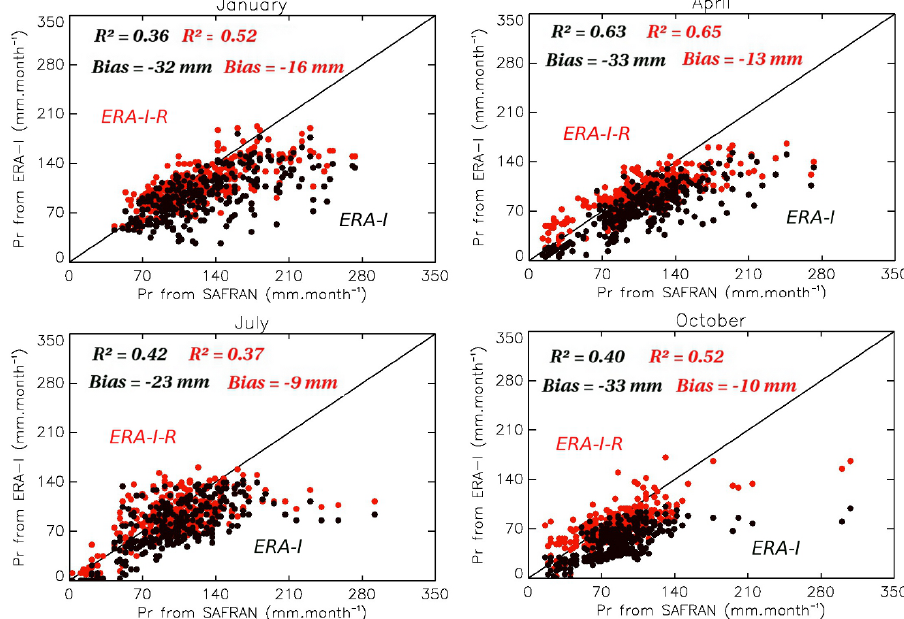
Fig. 6. Spatial correlation of the monthly precipitation data from ERA-I and ERA-I-R (308 grid-cells) with SAFRAN, in January, April, July, and October 2001. Table 3. Representation of the seasonal variability in large scale precipitation products over France: mean monthly bias (large scale prod- uct minus SAFRAN), RMSE and squared correlation coefficient, for ERA-I, ERA-I-R, GPCC and GPCP with respect to SAFRAN data precipitation. Years 2001, 2003 are considered, together with the 1991–2008 period (ERA-I, ERA-I-R, GPCP) or the 1991–2007 period